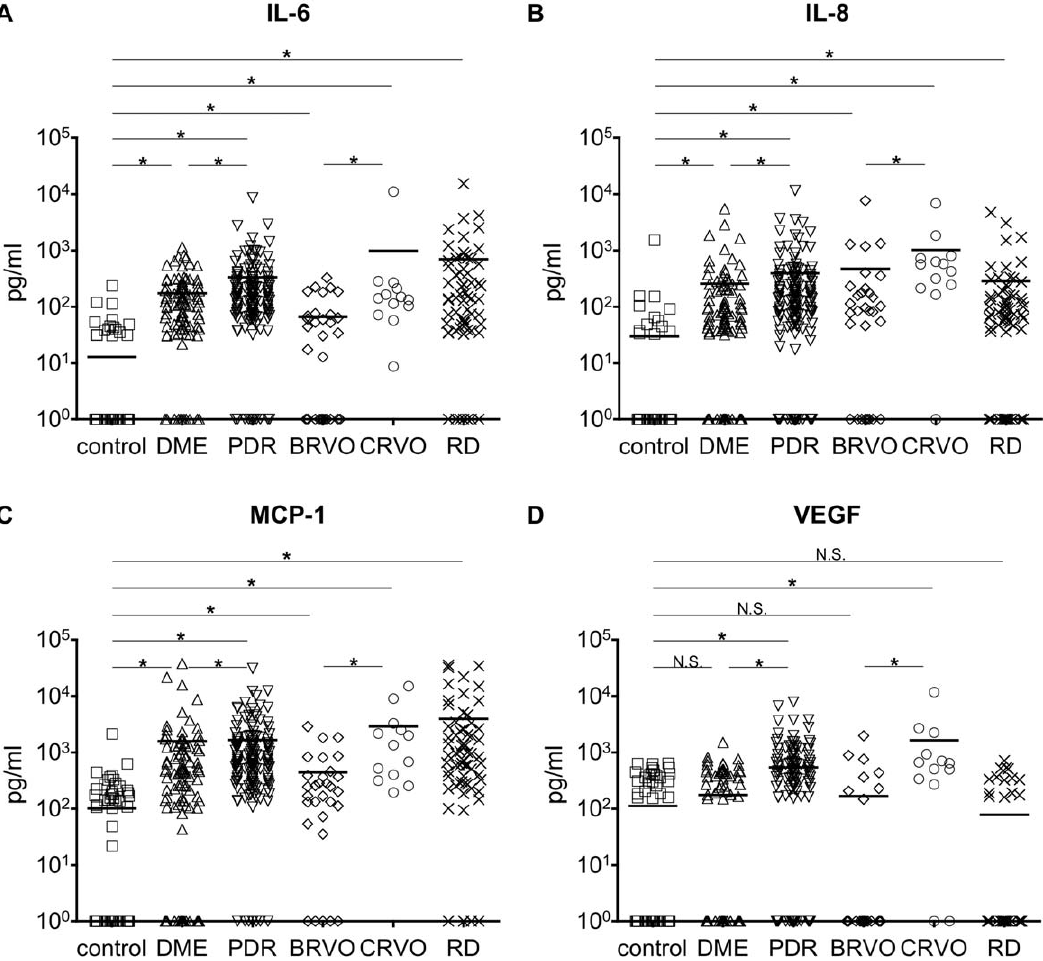
Figure 1. Detection of soluble factors in vitreous fluids from patients. (A) IL-6, (B) IL-8, (C) MCP-1, and (D) VEGF levels in vitreous fluid of control patients and patients with DME, PDR, BRVO, CRVO, and RRD. The ordinate showed the concentrations of soluble factors in the log scale, bars represent the mean value of each group. * P , 0.05, N.S.: not significant. doi:10.1371/journal.pone.0008158.g001 PLoS ONE |